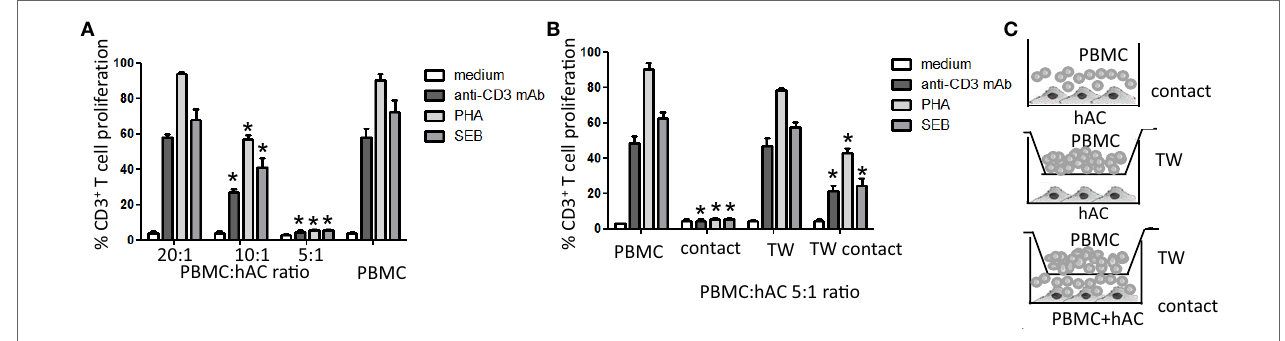
FigUre 2 | human articular condrocyte (hac) regulate T cell proliferation . (a) T cell proliferation of CD3 + T cells with the indicated stimuli at different PBMC:hAC ratio (20:1, 10:1, 5:1) or PBMC alone (medium). (B) T cell proliferation of PBMC on hAC at the PBMC:hAC ratio of 5:1 in contact or separated by a Millicell transwell chamber (TW, PBMC in TW) or by PBMC in TW separated by a co-cultures of PBMC and hAC (TW-contact). Results are the mean ± SD of eight different experiments. (c) Schematic representation of the different culture conditions: contact (a,B) , TW (B) , and TW-Contact (B) . * p < 0.001 vs.